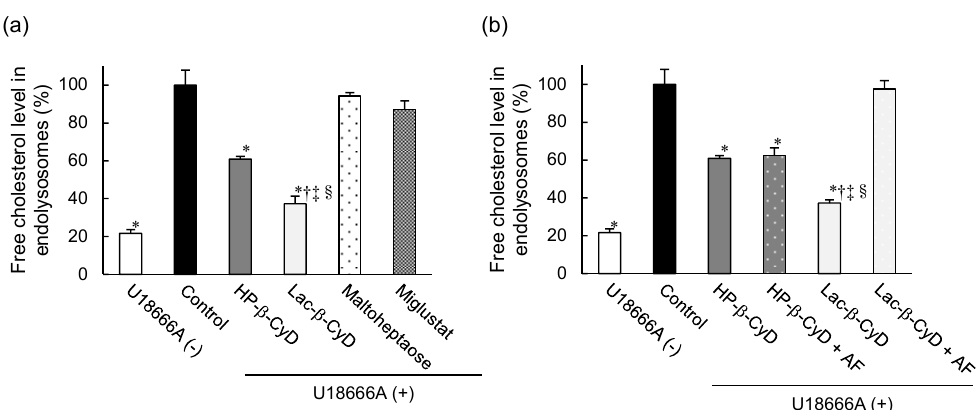
Figure 6. Free cholesterol-lowering effect of Lac- β -CyD in NPC-like liver cells. ( a ) U18666A-treated HepG2 cells were incubated with culture medium containing Lac- β -CyD, HP- β -CyD, miglustat, or maltoheptaose (1 mM, 24 h) at 37 °C, and fixed in 4% PFA. Fluorescence of cells stained with Filipin III (cholesterol) and LysoTracker ® Green DND-26 (endolysosomes). Quantification of Filipin III fluorescence intensity in endolysosomes using ImageJ software. Each value represents the mean ± S.E.M. of 3 experiments. * p < 0.05, compared to control; † p < 0.05, compared to HP- β -CyD; ‡ p < 0.05, compared to maltoheptaose; § p < 0.05, compared to miglustat. ( b ) Effect of AF on the Lac- β -CyD free cholesterol lowering effect in endolysosomes of U18666A-treated HepG2 cells. Cells were exposed to culture medium containing Lac- β -CyD or HP- β -CyD (1 mM) ± AF (1.0 mg/mL) for 24 h at 37 °C. Fluorescence of cells stained with Filipin III (cholesterol) and LysoTracker ® Green DND-26 (endolysosomes). Quantification of Filipin III fluorescence intensity in endolysosomes using ImageJ software. Each value represents the mean ± S.E.M. of 3 experiments. * p < 0.05, compared to control; † p < 0.05, compared to HP- β -CyD; ‡ p < 0.05, compared to HP- β -CyD + AF; § p < 0.05, compared to Lac- β -CyD + AF.